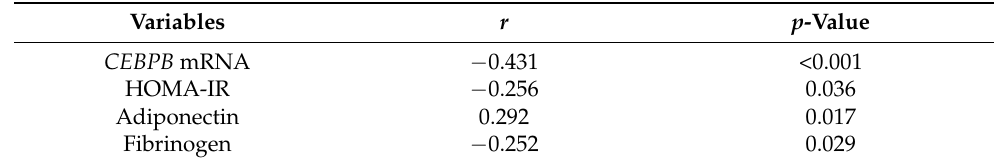
Figure 5. Expression of miR-155 and CEBPB mRNA according to HOMA-IR values of obese patients (n = 80). Data are shown as box plots and were compared by the Mann–Whitney U test. p < 0.05. Patients were grouped according to the HOMA-IR values using the first quartile (25th percentile-p25, HOMA-IR = 2.6) and the third quartile (75th percentile-p75, HOMA-IR = 7.6) as cut-off values. HOMA-IR: Homeostasis model assessment of insulin resistance. Table 3. Significant correlation of miR-155 with CEBPB expression and other variables in obese patients ( n =